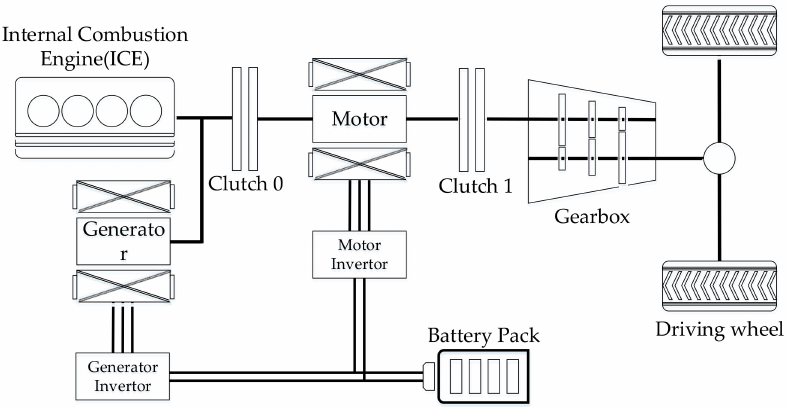
Figure 6. The schematic of the PHEV